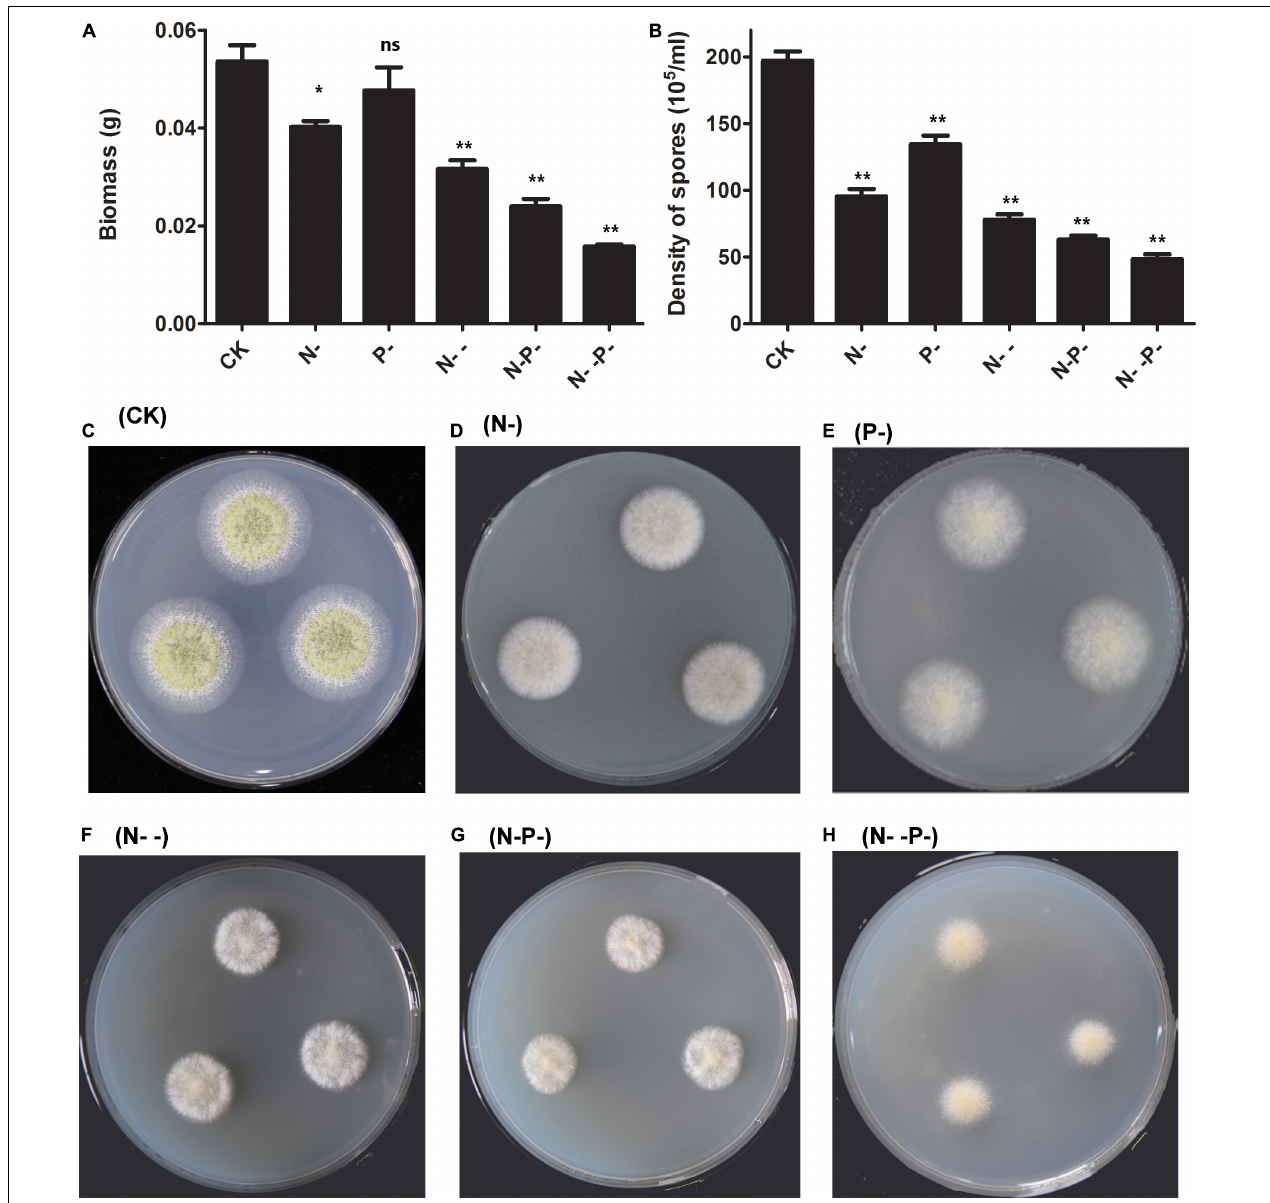
FIGURE 1 | The dry biomass and density of spores as affected by nitrogen and phosphorus. (A) The dry biomass under nitrogen and phosphorus limitation and the control. The mycelia were collected by peeling them off from the plates and dried overnight for the determination of biomass. (B) The density of spores under nitrogen and phosphorus limitation and the control. (C–H) The phenotype of A. oryzae strain under the condition of control and distinct N/P limitation. CK, N-, P-, N- -, N- P-, and N- -P- represent the control and distinct N/P-limited groups, respectively. The bars represent the average ( ± SE) of biological repeats. Asterisks indicate statistically significant differences between groups (Student’s t -test): * p < 0.05, ** p < 0.01, ns, no significant